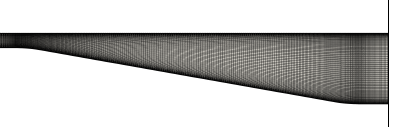
Figure 14. Mesh at the expansion section of the diffuser